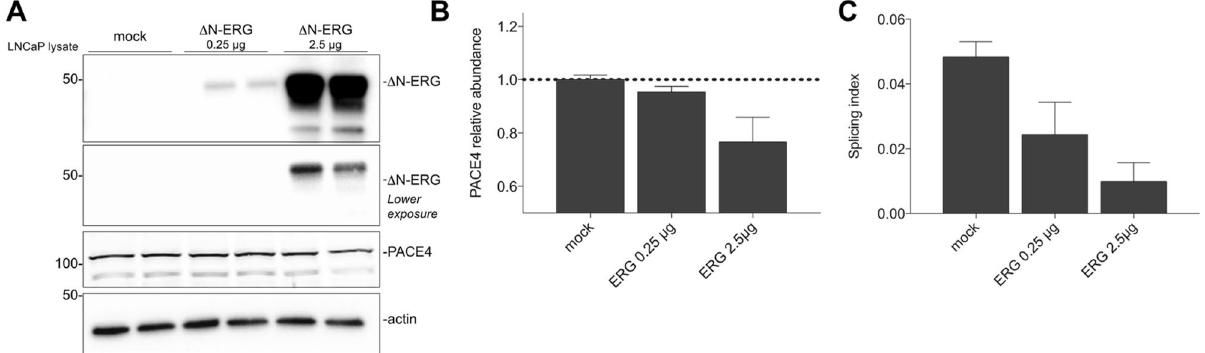
Figure 1. Relationship between PACE4-altCT and ERG status in prostate cancer cells. ( A ) Western blot analysis on LNCaP cell lysates following transfections with the indicated vectors. Each lane represent an individual transfection. ERG is shown with distinct exposures. These blots were cropped to emphasize the intended band. Uncropped original blots are provided as in Supplementary Material. ( B ) PACE4 densitometry analysis using actin as a reference. Data are mean ± SEM. ( C ) PACE4 splicing indices determined by RT-qPCR in transfected LNCaP cells. Data are mean ± SEM (n =